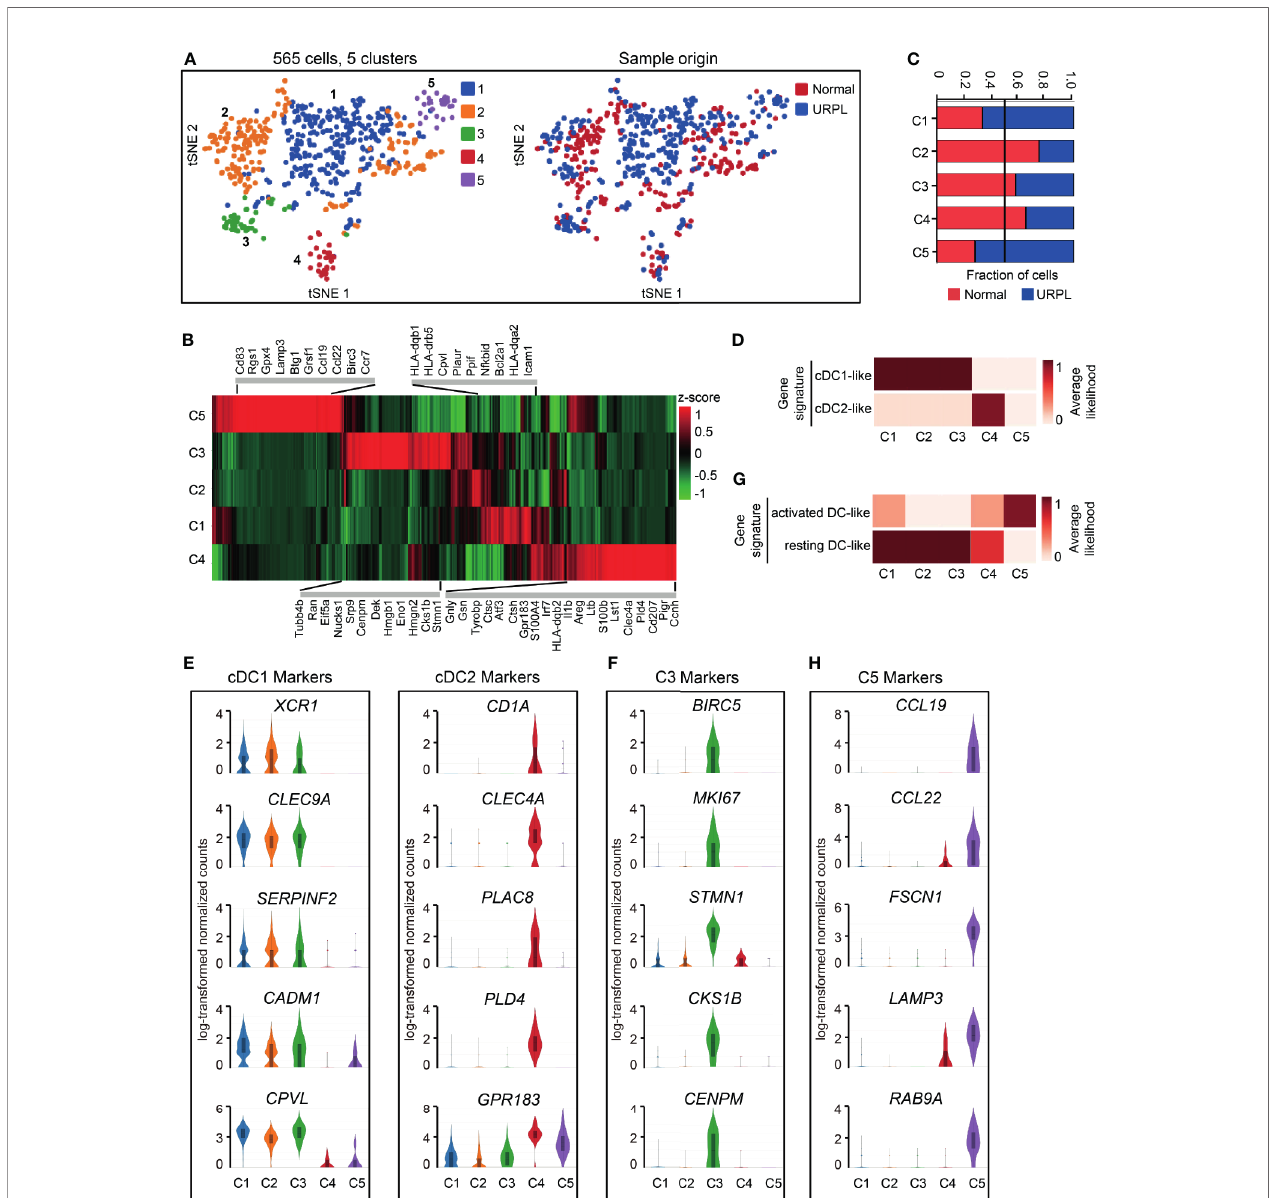
FIGURE 6 | Single-cell data revealed molecular details and subclusters of DCs in decidua. (A) tSNE of the DC as de fi ned in Figure 1A , with each cell colorcoded for (left to right): the associated cell type and its sample type of origin (normal or URPL). (B) Heatmap of enriched genes expression within de fi ned subclusters above. Gene expression was measured in units of log2. (C) The fraction of cells originating from URPL and normal control samples for the 5 subclusters. (D) Classi fi cation of DC subsets by cDC1- and cDC2-like gene signatures. (E) Violin plots showing the smoothened expression distribution of cDC1 and cDC2 marker genes in the 5 DC subclusters. (F) Violin plots showing the smoothened expression distribution of differentially expressed genes in cluster 3 DCs. (G) Classi fi cation of DC subsets by ‘ activated ’ and ‘ resting ’ state gene signatures. (H) Violin plots showing the smoothened expression distribution of differentially expressed genes in cluster 5 DCs. Analysis of gene expression in scRNA-seq data was performed in R (version 3.5.2) using